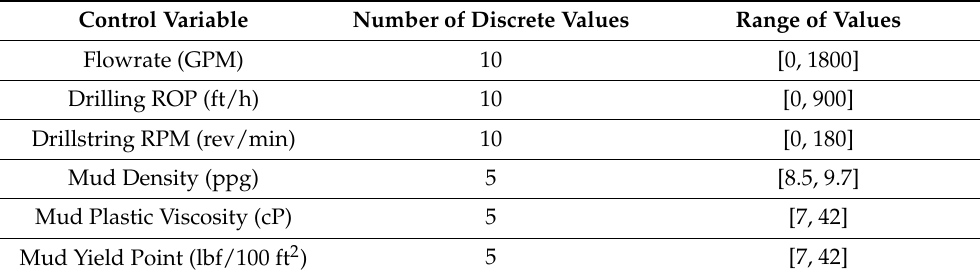
Table 2. Number and ranges of values for the different control variables to define the action-space.